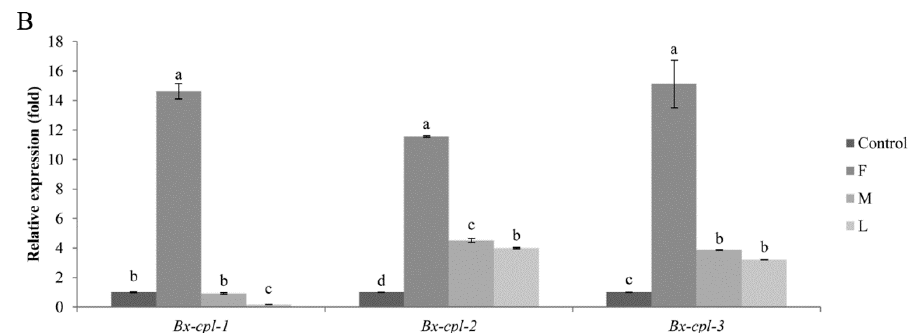
Figure 5. Symptoms in P. massoniana after inoculation with nematodes: ( A ) First stage of pine wilt disease (PWD) (F), middle stage of PWD (M), and last stage of PWD (L). Pines inoculated with ddH 2 O (1); Pines inoculated with B. xylophilus (2). Relative expression levels of Bx-cpl s at PWD development stages ( B ). The bars indicate standard errors, and different letters indicate significant differences ( p < 0.05).